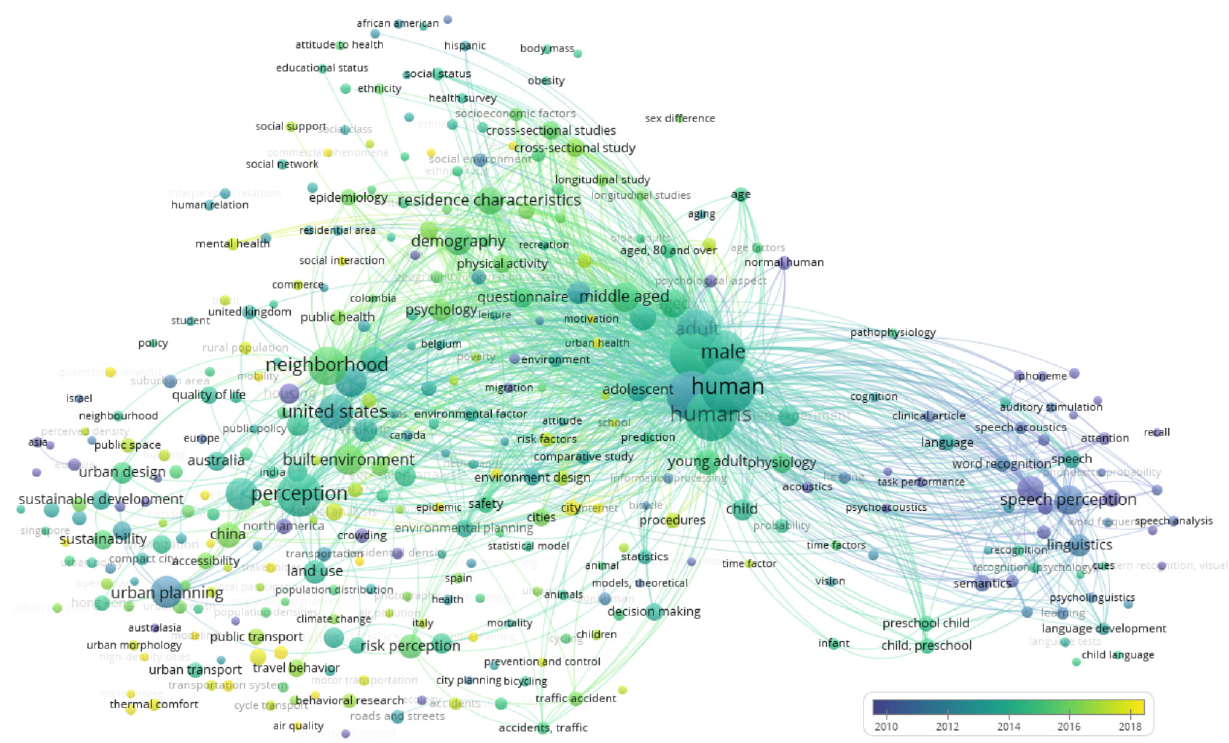
Figure 5. Visualisation of the co-occurrence of the selected literature including 354 keywords out of 4646 keywords with minimum number of five occurrences.